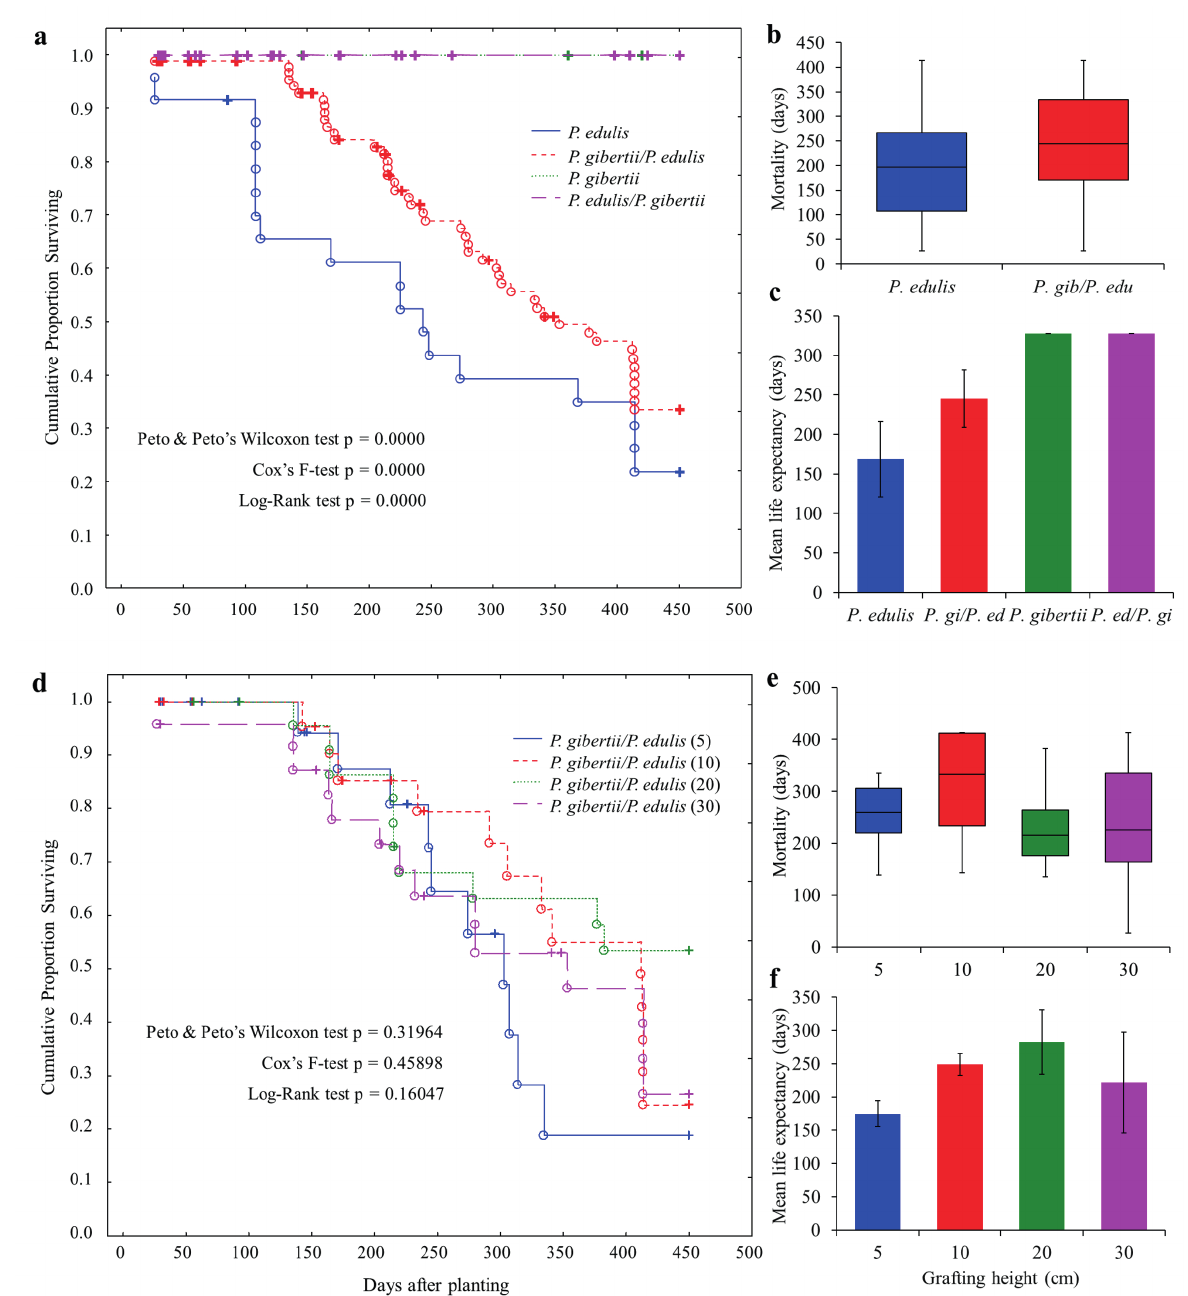
Figure 5 - ( a ) Cumulative survival rate of P. edulis (non-grafted) P. gibertii P. gibertii/P. edulis and P. edulis/P. gibertii to Fusarium wilt ( Fop ). ( b ) boxplot of Fop survival (days) of P. edulis (non-grafted) and P. gibertii/P. edulis . ( c ) average survival time to Fop of the non-grafted P. edulis and P. gibertii and combination P. gibertii/P. edulis and P. edulis/P. gibertii . ( d ) cumulative survival ratio to Fop of P. gibertii / P. edulis at grafting heights of 5 cm, 10 cm, 20 cm and 30 cm. ( e ) boxplot of Fop survival (days) of P. gibertii/P. edulis at different grafting heights. ( f ) mean survival time to Fop (days) of P. gibertii/P. edulis with grafting heights of 5 cm, 10 cm, 20 cm and 30